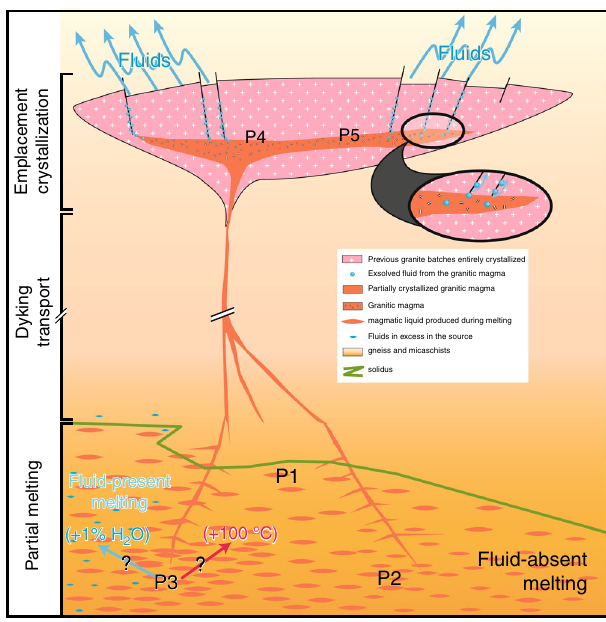
Fig. 6 Illustration linking P1 – P5 MT anomalies to magmatic processes and crustal-scale transfer of water. The magmatic conditions at the P1 – P5 electrical anomalies are given in Table 3. By these magmatic processes, water is transferred from the lower crust (depth >20 km), where partial melting occurs, to the emplacement/crystallization zone of granites (depth = ca. 10 – 12 km). Aqueous fl uids released from solidifying granites may well signi fi cantly contribute to the numerous hot springs suggested from their geochemical features 47 . Fluid-absent melting under conditions similar to the G1 P – T path can explain the Northwestern Tibet, while beneath the Southern Tibet, either fl uid-present melting or a warmer crust is